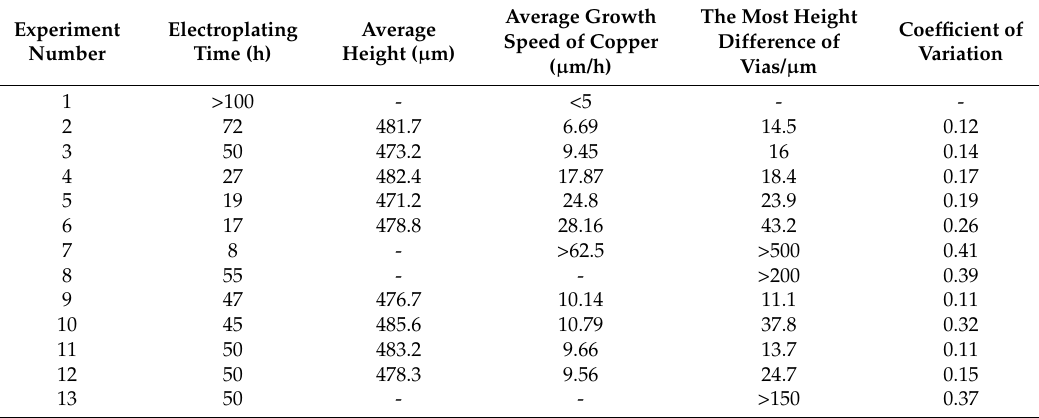
Table 3. Electroplating experiment